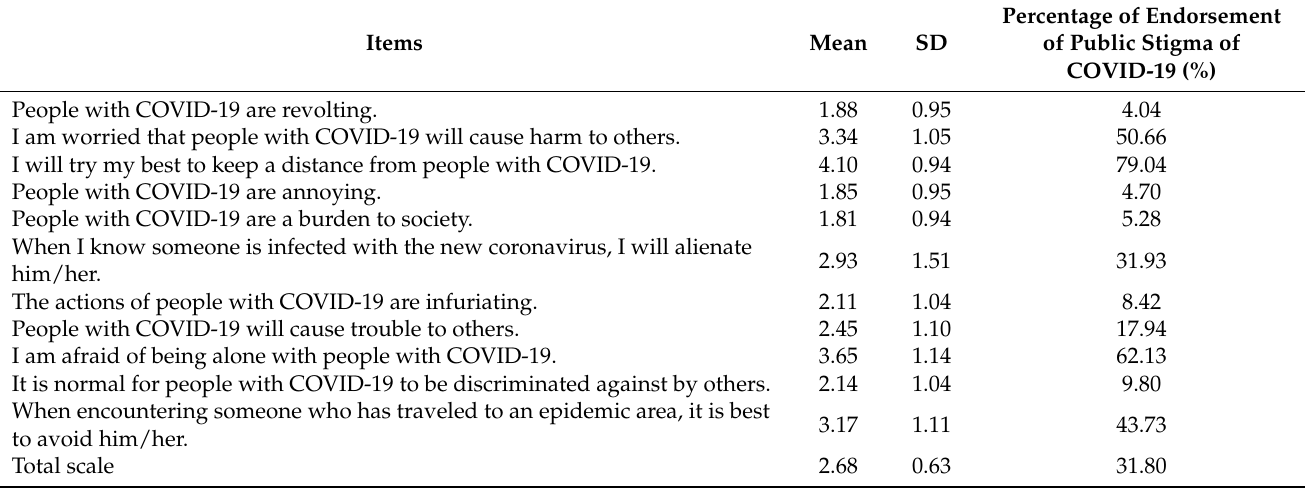
Percentage of Endorsement